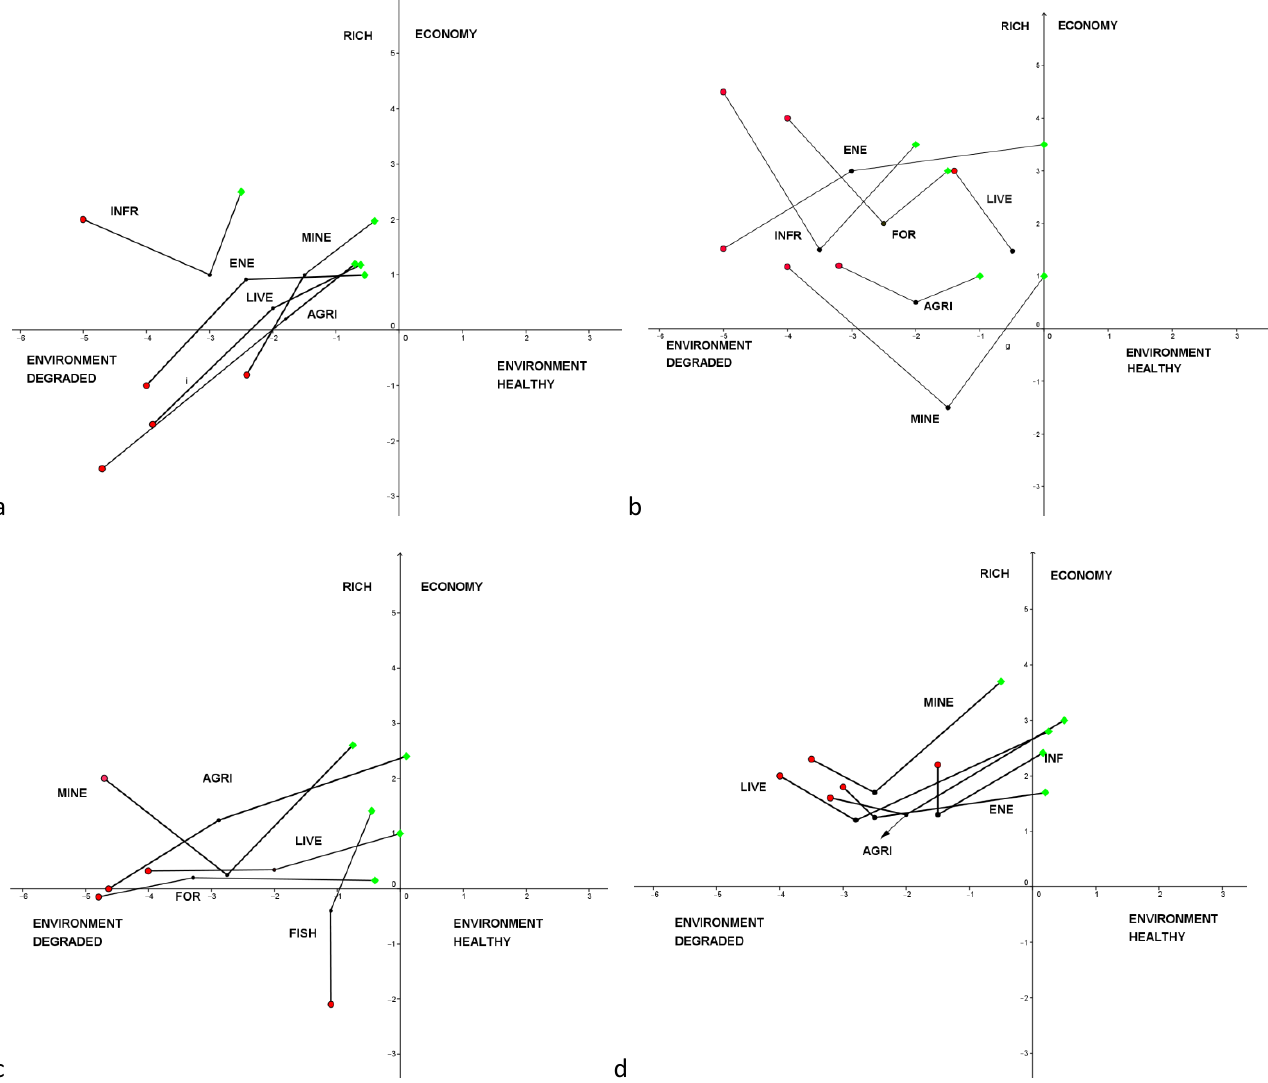
Fig. A1.2. Economic sectors positions and trajectories in current situation and business as usual and green economy scenarios in the units of analysis: a) Central, b) Eastern, c) Lake, d) Northern, e) Southern highlands, f) Southern, g) Western. Stakeholders analysed agriculture (AGRI), livestock (LIVE), energy (ENE), forestry (FOR), mining (MINE), infrastructure (INF) and fishery (FISH) sectors. Black, red and green dots represent positions in current situation, business as usual and green economy scenarios